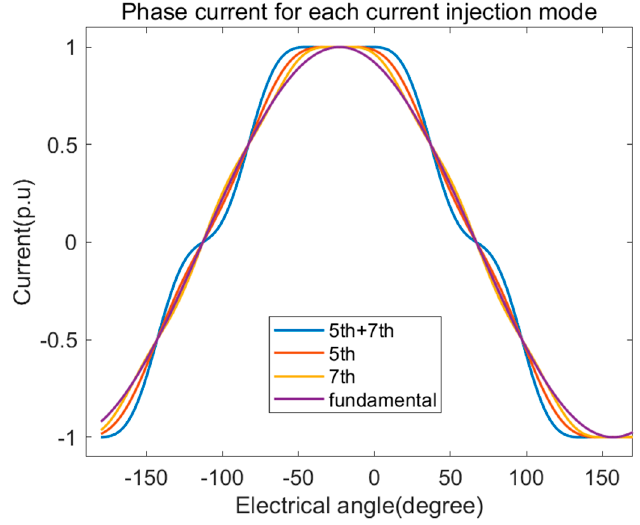
Table 2. Design specifications of a six-phase PMSM.